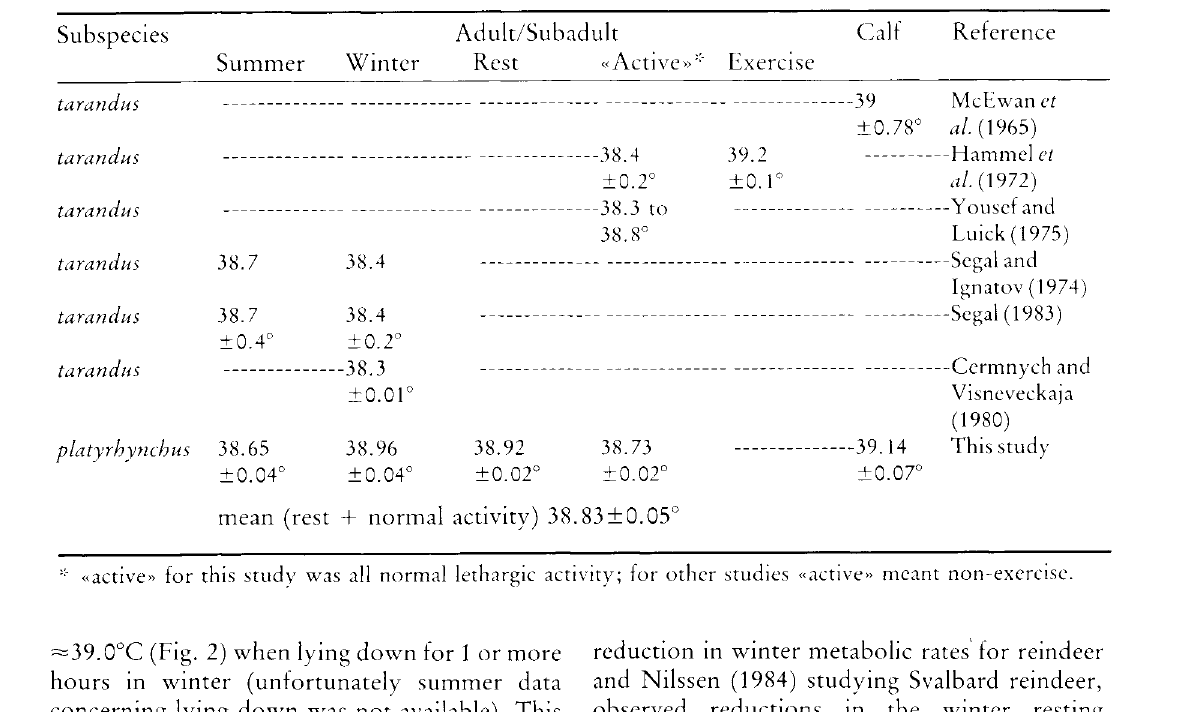
Table 1. Mean body temperature (°C) of reindeer/caribou, Rangifer tarandus Subspecies Adult/Subadult Calf